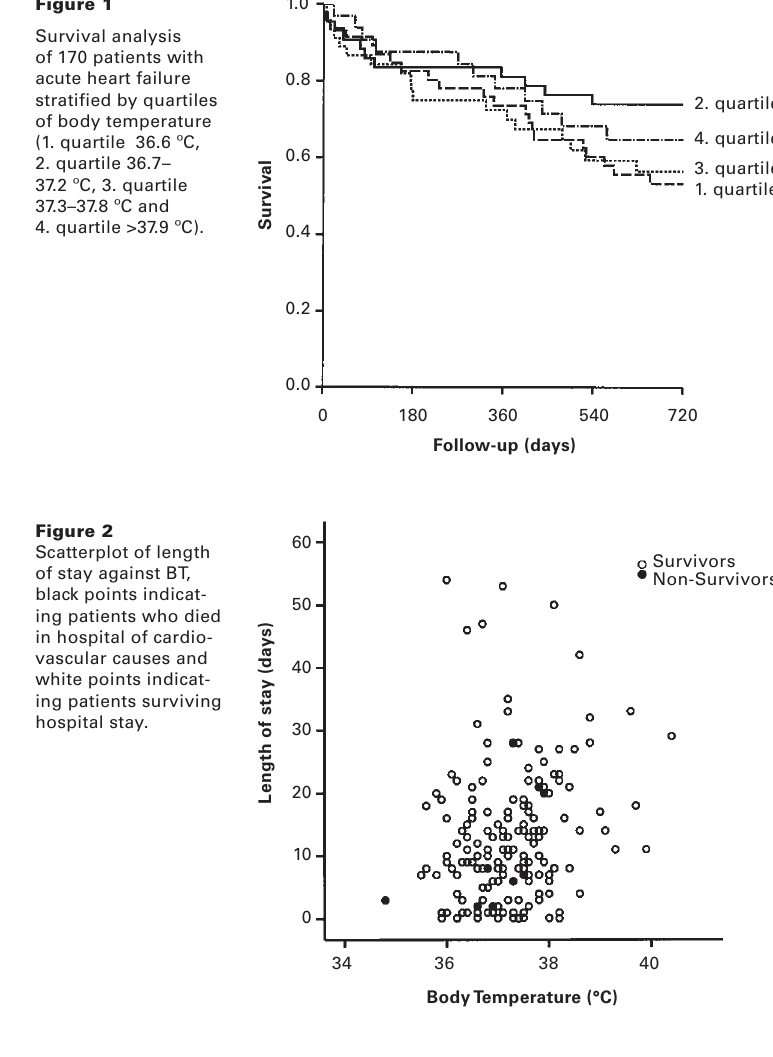
Survival analysis of 170 patients with acute heart failure stratified by quartiles of body temperature (1. quartile 36.6 ºC, 2. quartile 36.7– 37.2 ºC, 3. quartile